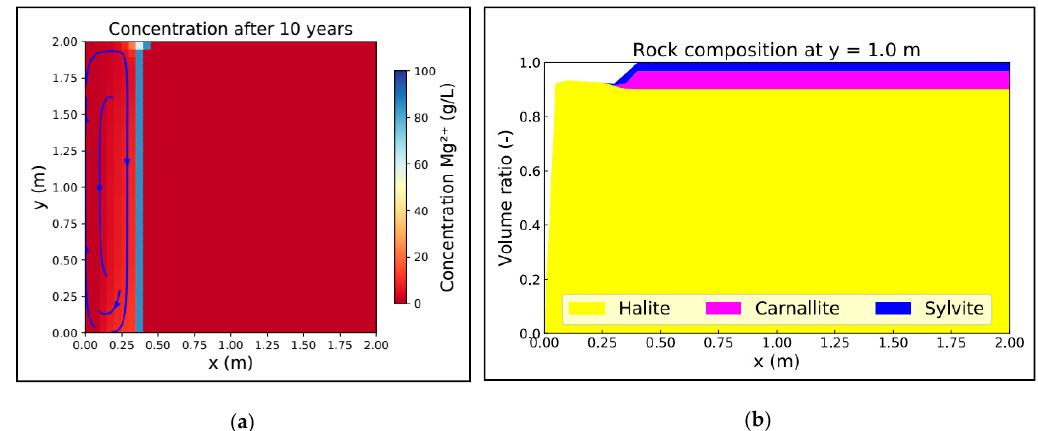
Figure 8. ( a ) Mg 2+ concentration distribution and ( b ) mineralogy for a reaction- and diffusion-dominated system (scenario: dissolution rate 10 − 6 cm/s and 5 wt.% carnallite).